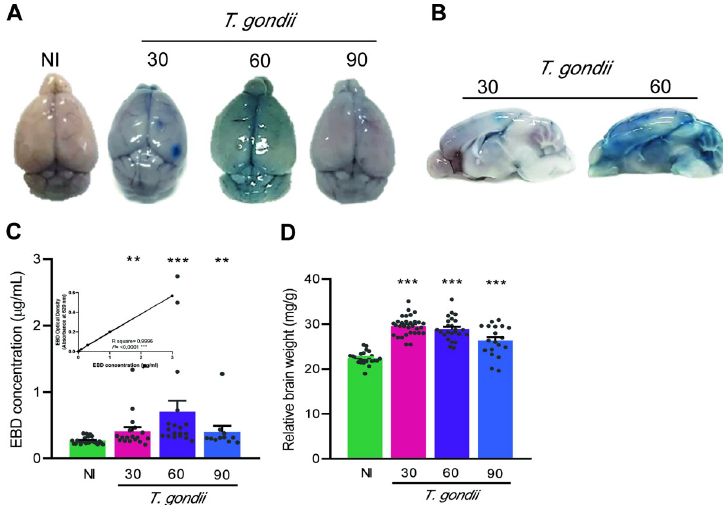
Fig 10. The increase in BBB permeability is concomitant with edema in Toxoplasma gondii -infected C57BL/6 mice. ( A ) Representative images of brains depicting EB extravasation at the timepoints assessed. ( B ) Representative sagittal sections of the encephala, at 30 and 60 dpi. ( C ) The concentrations of EB in the brain tissue of infected mice increased at the three studied timepoints, indicating the increase in BBB permeability. ( D ) Cerebral edema, manifested by a significant increase in the relative brain weight (brain weight in milligram / whole body weight in gram), was present in the timepoints evaluated. Each experimental group consisted of 4–6 NI mice and 8–19 T . gondii-i nfected mice, in two independent experiments. Each circle represents an individual mouse. The data are expressed as means ± SEM, and were analyzed using Mann-Whitey test ( C ) and t- Student test ( D ). �� , p < 0.01. ��� , p < 0.001, comparing T . gondii- infected and NI